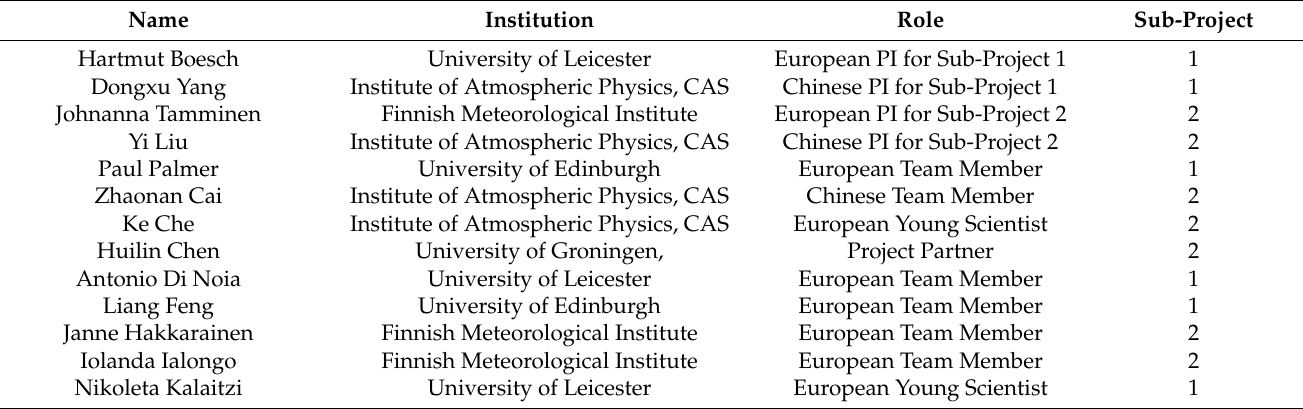
Table 2. Overview over project